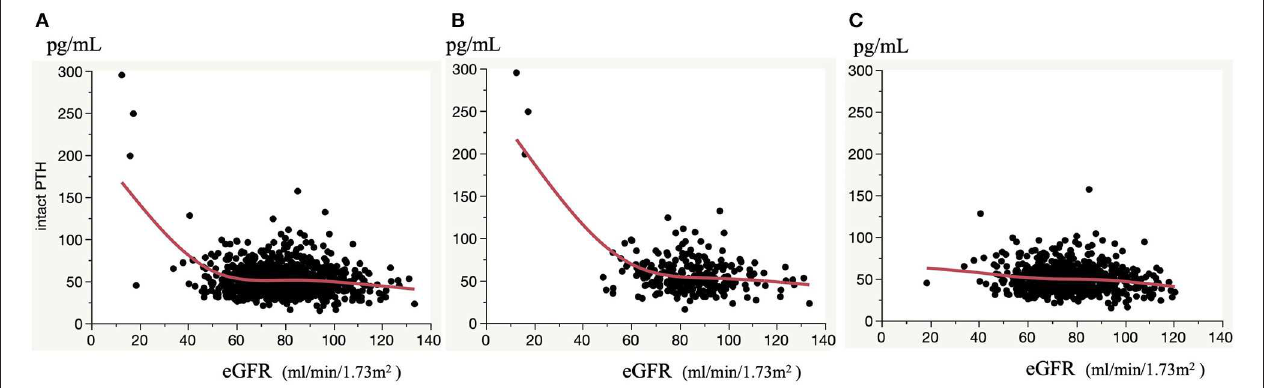
FIGURE 2 | Correlation between eGFR and serum intact PTH concentrations. Correlation in all participants (A) , and participants with vitamin D deficiency (B) and non-vitamin D deficiency (C) . Smoothed spline curves are shown in each panel.